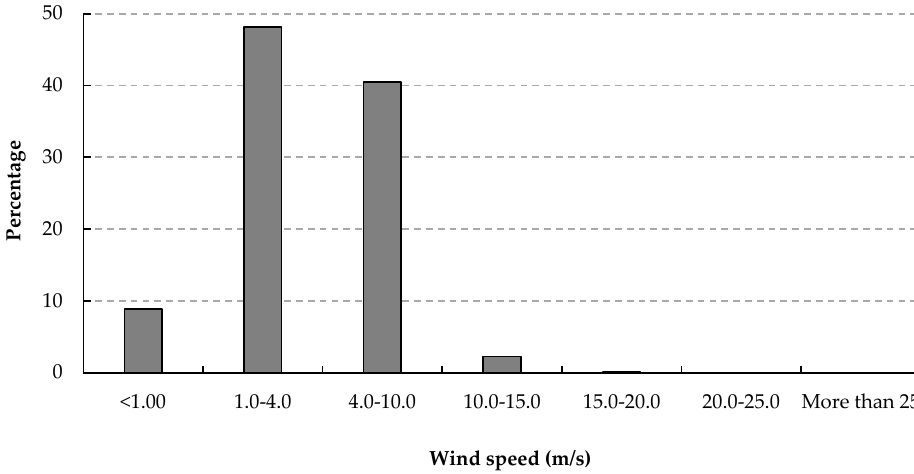
Figure 10. Wind class frequency distribution of Aligudarz station.